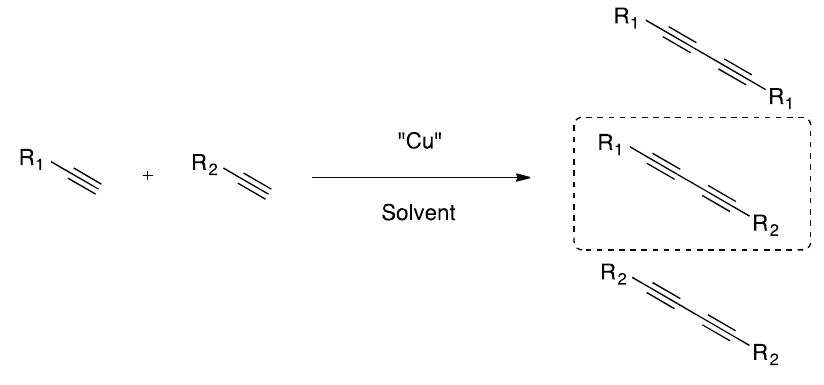
Figure 1. Chemoselectivity of the Glaser-Hay